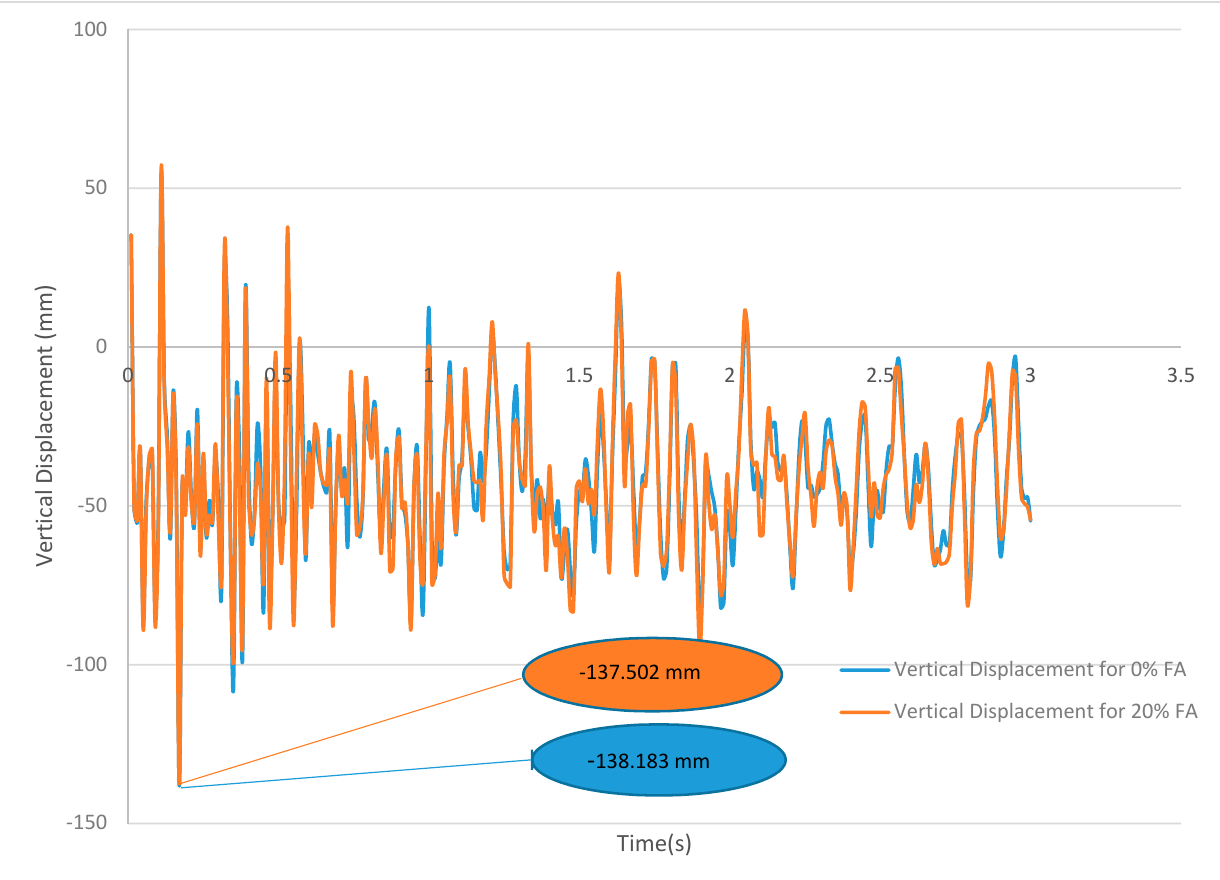
Figure 28. Comparison of time-history curves for vertical displacement of the pipe crown with the inclusion of 20% and 0% FA due to the Friuli earthquake.